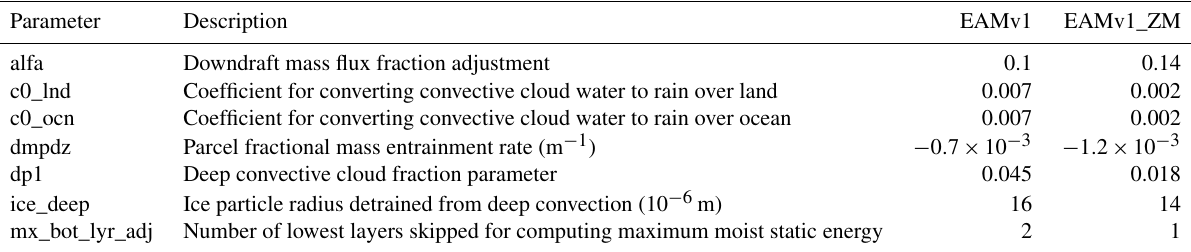
Table 1. Description of tunable parameters and their values in EAMv1 and EAMv1_ZM. Parameter Description